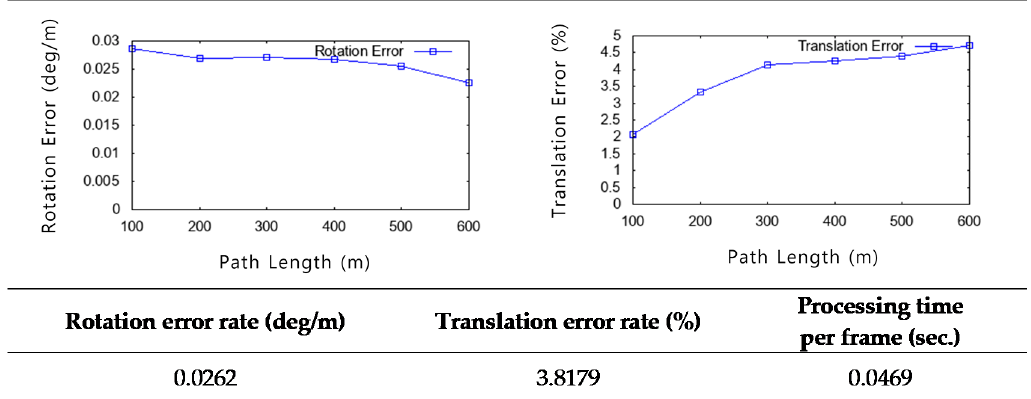
Figure 20. Graph of error over mileage for sequence 06.